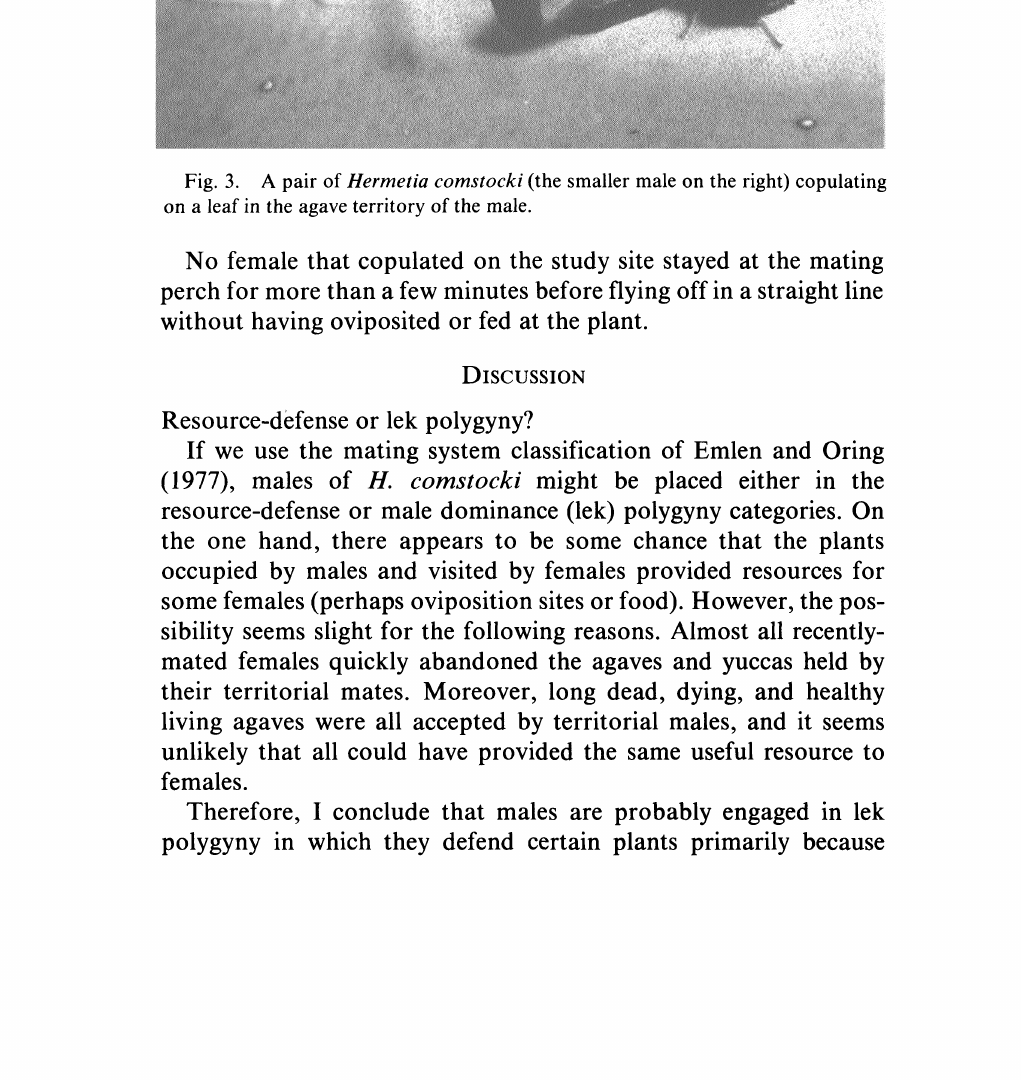
Fig. 3. A pair of Hermetia comstocki (the smaller male on the right) copulating on a leaf in the agave territory of the